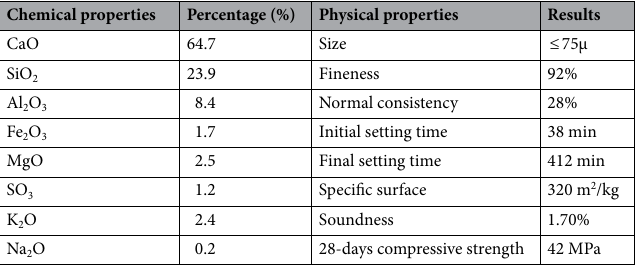
Table 1. Physical and chemical properties of OPC